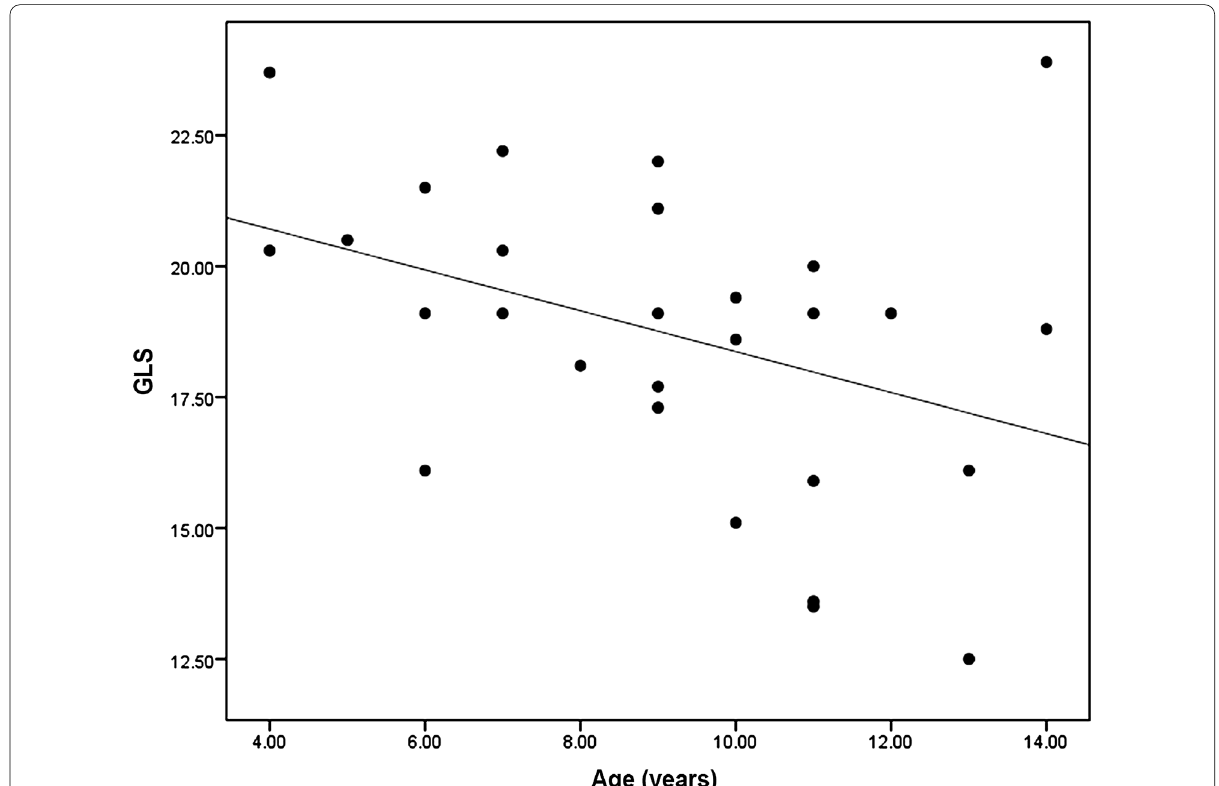
Fig. 2 Correlation between age of DMD patients and